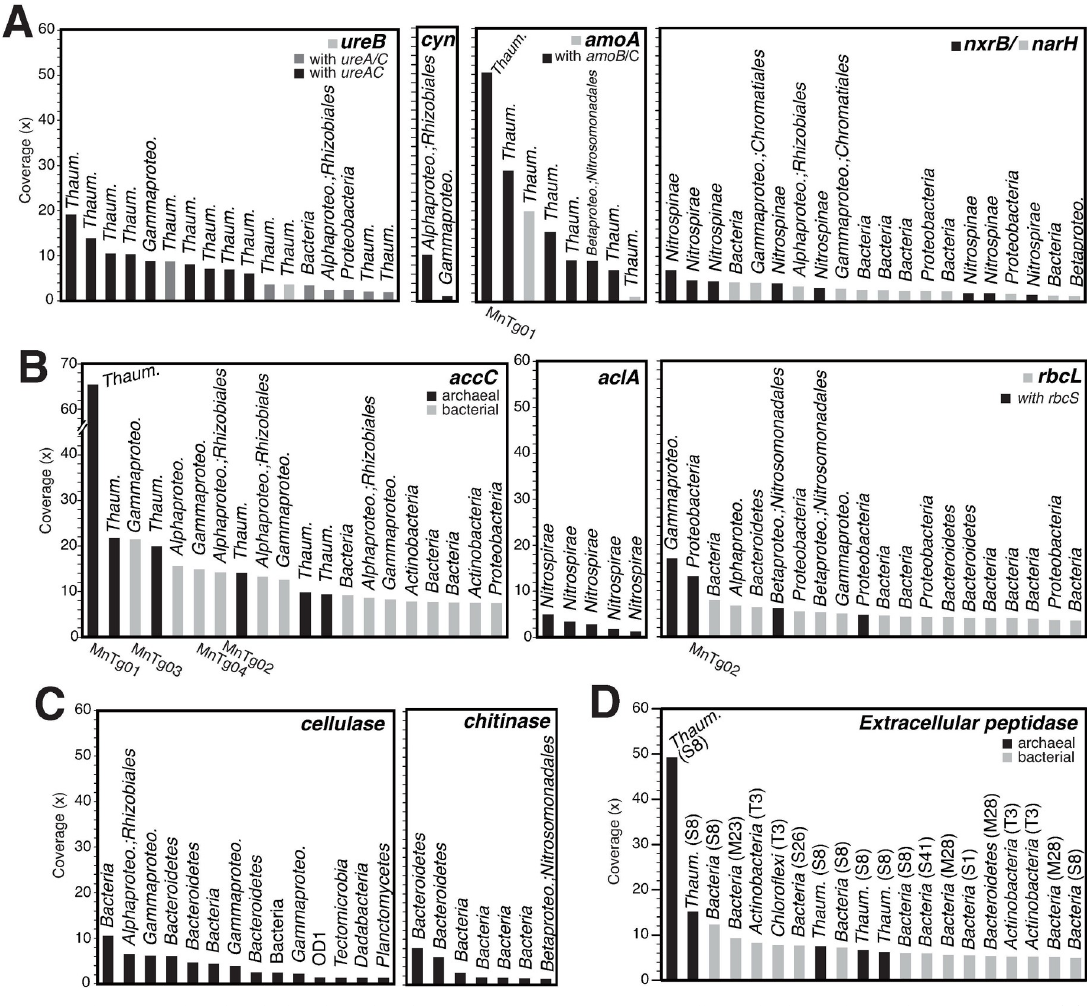
Fig 2. Read-coverage-based rank abundant plot of contigs containing CDSs potentially involved in carbon and nitrogen cycling. (A) CDSs for UreB, Cyn, AmoA, and NxrB/NarH involved in nitrification. (B) CDSs for AccC, AclA, and RbcL for key enzymes in carbon fixation pathways. (C) CDSs for cellulase and chitinase. (D) CDSs for extracellular peptidases. Peptidase family names for S, T, and M are indicated in parentheses. Taxonomic affiliations for the CDSs are indicated on the bars. The IDs of metagenome-assembled genomes (MAGs) are shown for the contigs containing CDSs identical to those of the